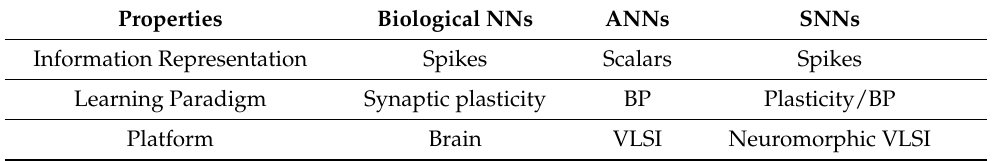
Table 1. A comparison of properties between biological neural networks, ANNs, and SNNs. Properties Biological NNs ANNs Information Representation Spikes